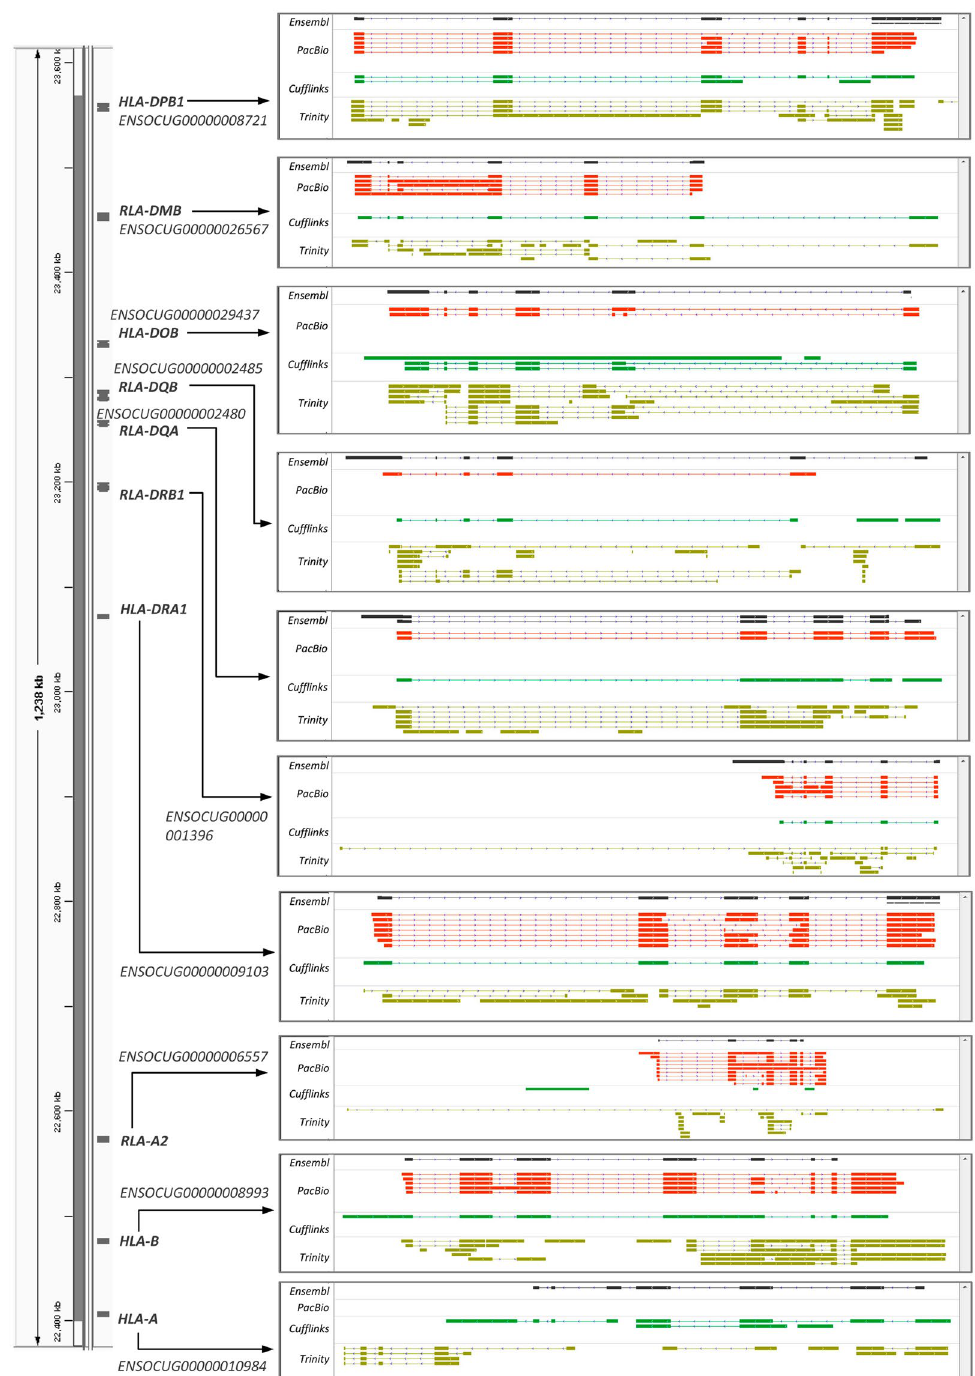
Figure 4. Recovery of ten MHC genes by PacBio transcripts and the assembled transcripts from short reads. Chromosomal locations, name and Ensembl accession number for each gene are shown on the left. The exon- intron structures are illustrated into the separate boxes and within each of them the reference transcripts in Ensembl (Black), PacBio transcripts (Red), and the assembled transcripts by Cufflinks (Green) and Trinity (Olive) are listed in order from top to